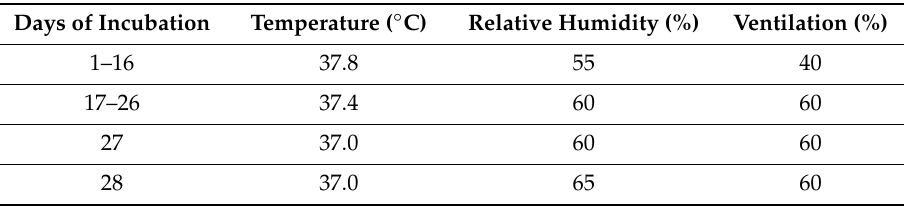
Table 1. Parameters of eggs